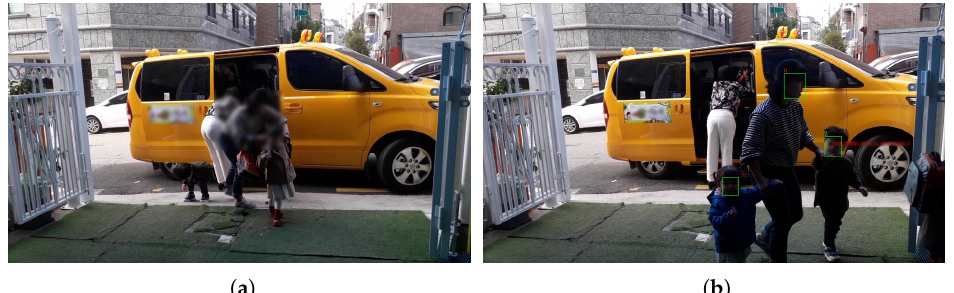
Figure 6. Images taken with a camera installed at the school bus traffic stop (Figure 4c): ( a ) example; ( b ) recognition result.